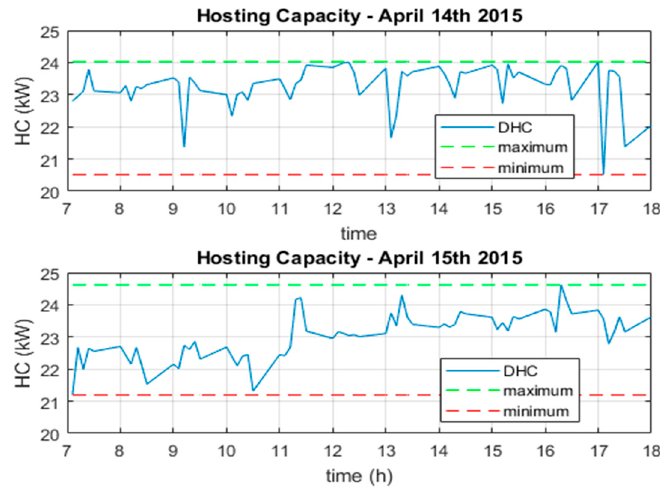
Figure 12. The daily DHC(t) for the in relation to April 12th and 13th, 2015.